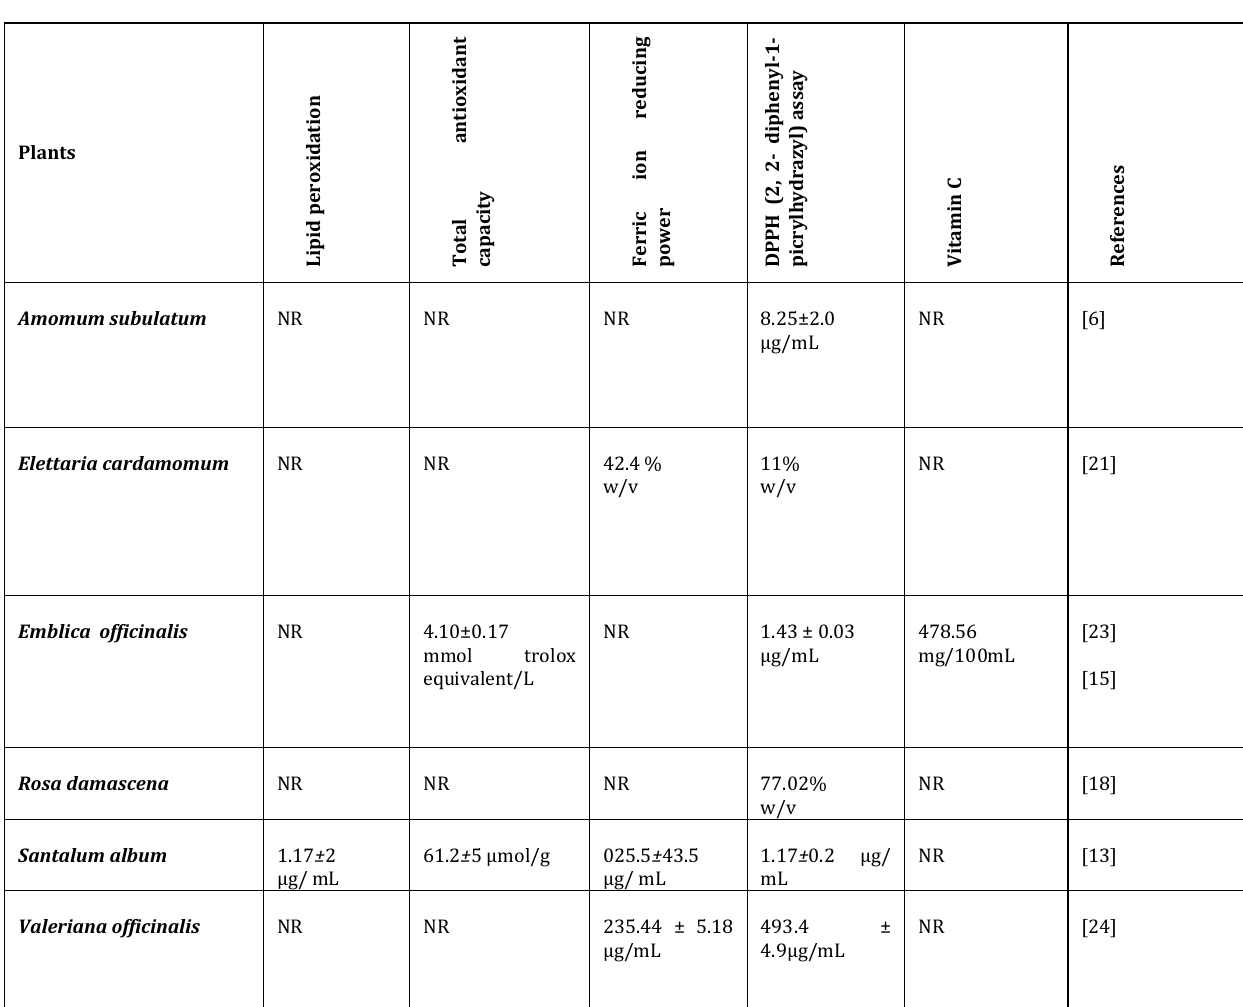
Table 3: Antioxidant analysis of the